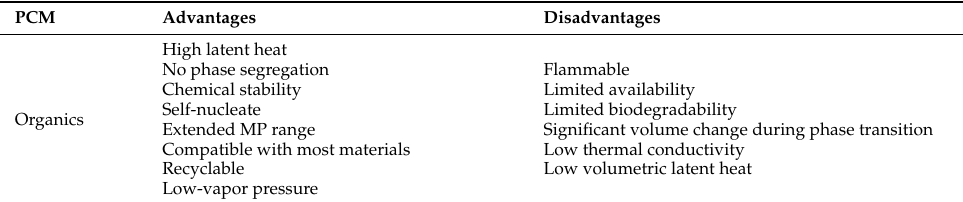
Table 1. Advantages and disadvantages of organic and inorganic PCMs. PCM Advantages Disadvantages High latent heat No phase segregation Chemical stability Self-nucleate Organics Extended MP range Compatible with most